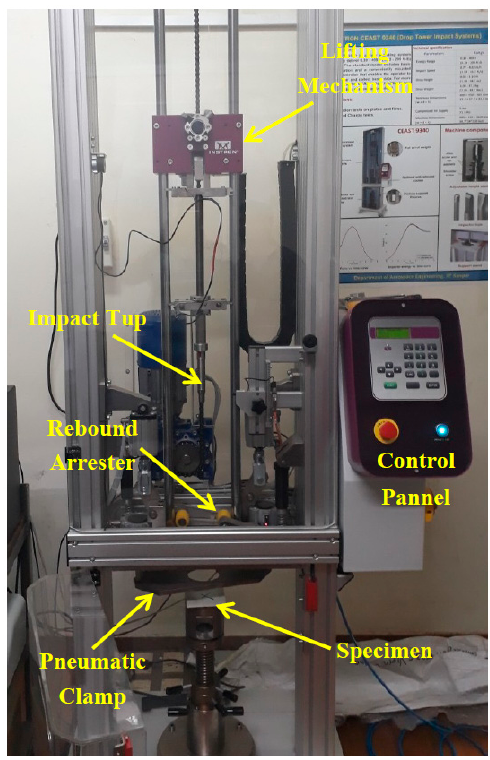
Figure 1. Instrumented low-velocity impact test facility.